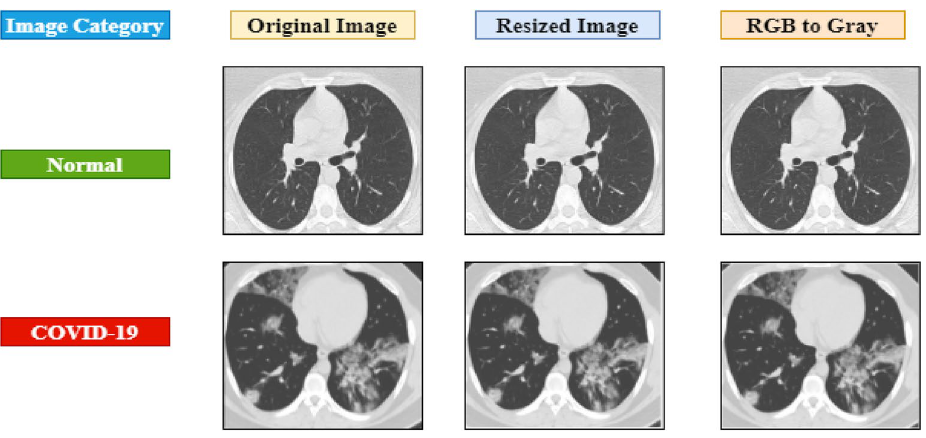
Figure 3. Image preprocessing